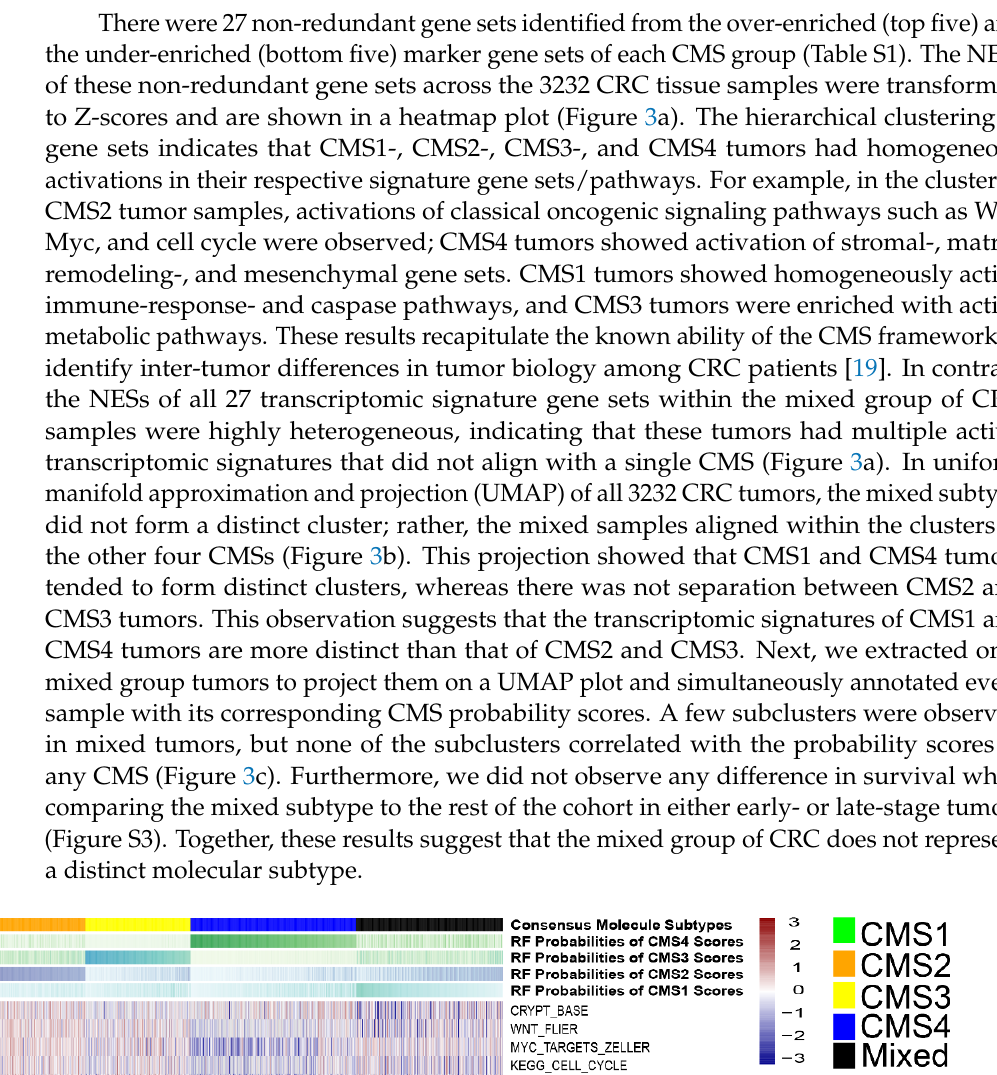
Figure 3. ( a ) Heatmap plot of normalized enrichment scores of 27 marker gene sets across 3232 CRC samples. ( b ) UMAP plot of all CRC patients projecting the distribution of different CMSs. ( c ) UMAP plots of tumor samples of mixed group depicting the distributions of all four CMS probability scores.